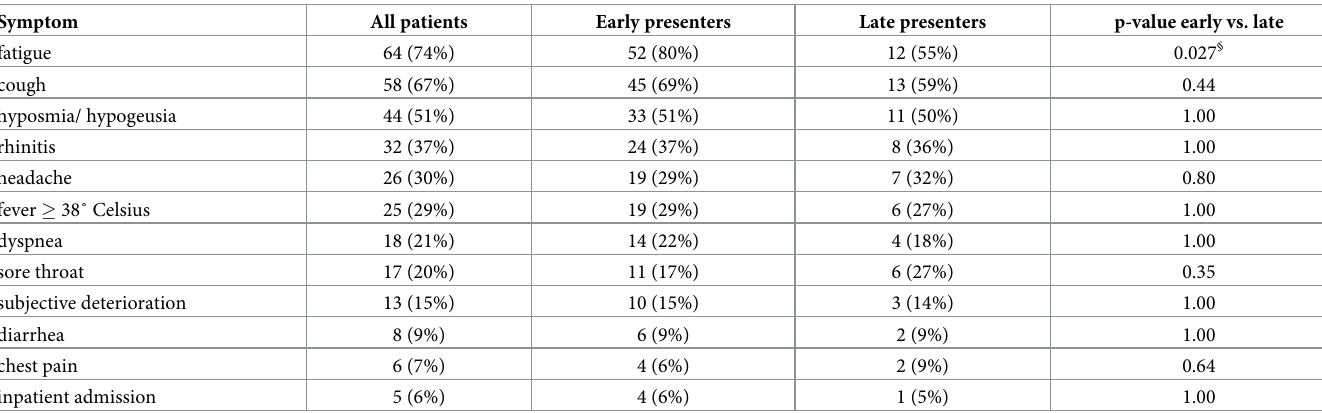
Table 1. Symptoms reported by outpatients diagnosed with coronavirus disease 2019 (Covid-19). Symptom All patients Early presenters Late presenters p-value early vs.